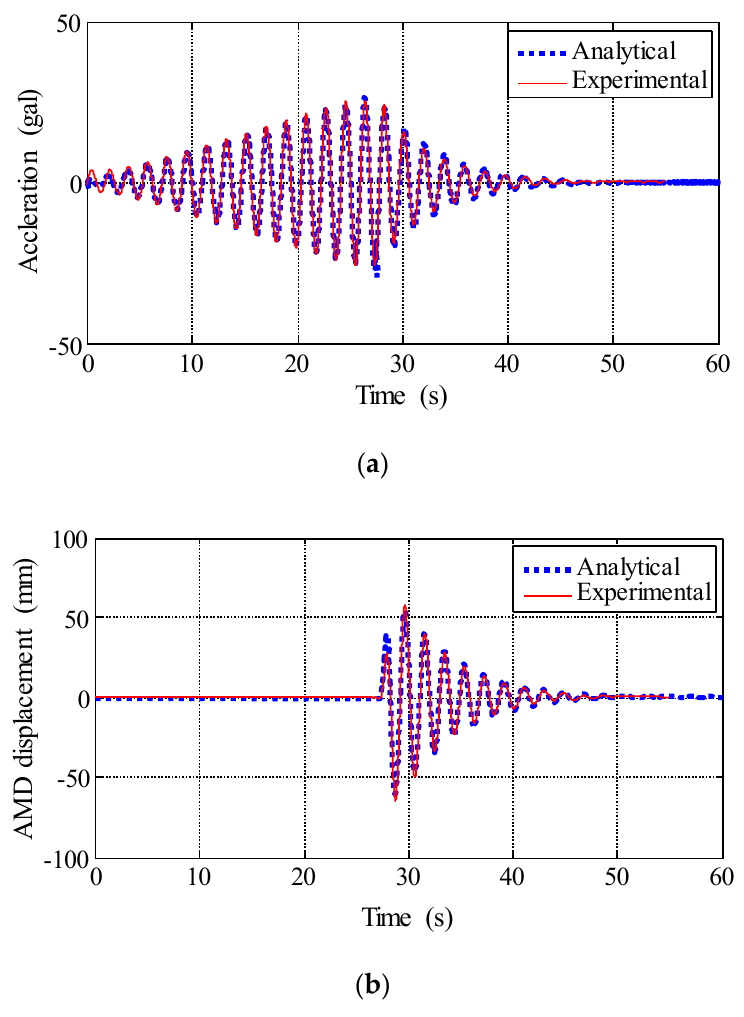
Figure 10. Comparison of experimental and analytical results: ( a ) acceleration of the bridge model and ( b ) displacement of the moving mass of AMD No. 1.